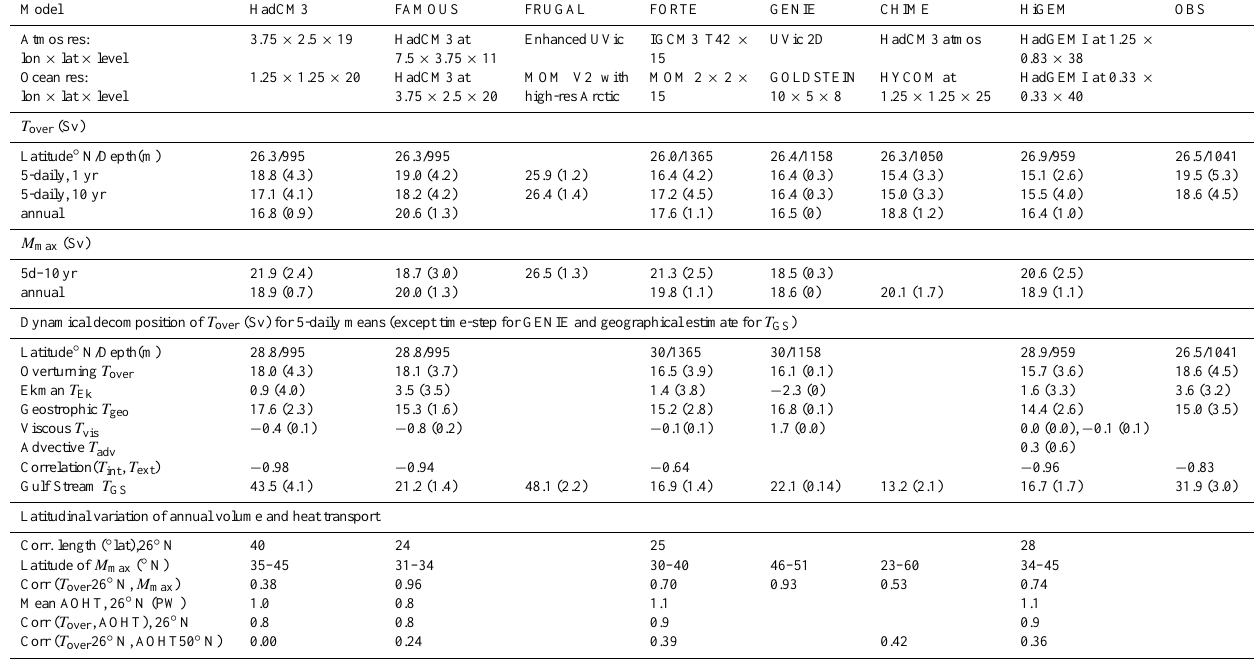
Table 1. Specifications of the RAPID-models; time-mean and standard deviations (X(Y) indicates X is mean and Y is SD) of simulated Atlantic Ocean meridional overturning transport (in Sv), T over , at 26 ◦ N and of the maximum of Atlantic MOC, M max on 5-daily and annual timescales; time-mean and standard deviation (SD) of the simulated 5-daily T over , 29 ◦ N and its decomposed components ( T Ek : Ekman part, T geo : geostrophic part, T vis : viscous/frictional part and T adv : advection part); time-mean of simulated annual Atlantic Ocean meridional heat transport (AOHT in PW), 26 ◦ N and the interannual correlation T over at 26 ◦ N with M max , AOHT at 26 ◦ N and AOHT at 50 ◦ N. The RAPID/MOCHA observational estimate (of 5yr) is given in the last column. The observed geostrophic transport is the sum of the mid- ocean transport and Florida current transport. The 1-yr statistics given for the 5-daily T over , at 26 ◦ N, is for the second year of the model integrations and the observations. In HiGEM and FORTE, the transport component due to viscous part has 2 parts namely, by the Laplacian and biharmonic terms. In FORTE, the biharmonic term is implicit and could not be calculated offline. The FRUGAL transport at 26 ◦ N is calculated along a curvilinear gridline which is near 26 ◦ N. Time-step data is used in GENIE which has an ocean time-step of 3.65days. GENIE and FRUGAL have no seasonal variability in wind-stress and no interannual variability. The Gulf Stream component ( T GS ) is not part of the physical decomposition; it is estimated geographically (see Sect. 4 for details). Meridional correlation length (in ◦ lat) at 26 ◦ N is defined as the latitudinal extent of positive correlation above 0.5 in both directions. FRUGAL and CHIME data are only available for some of the calculations.